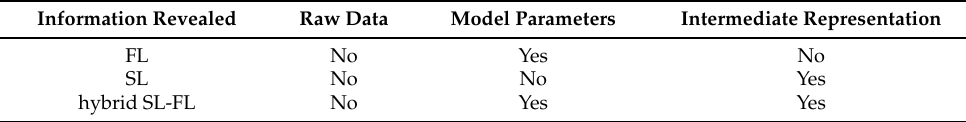
Table 5. Comparison of information exposure in FL, SL, and hybrid